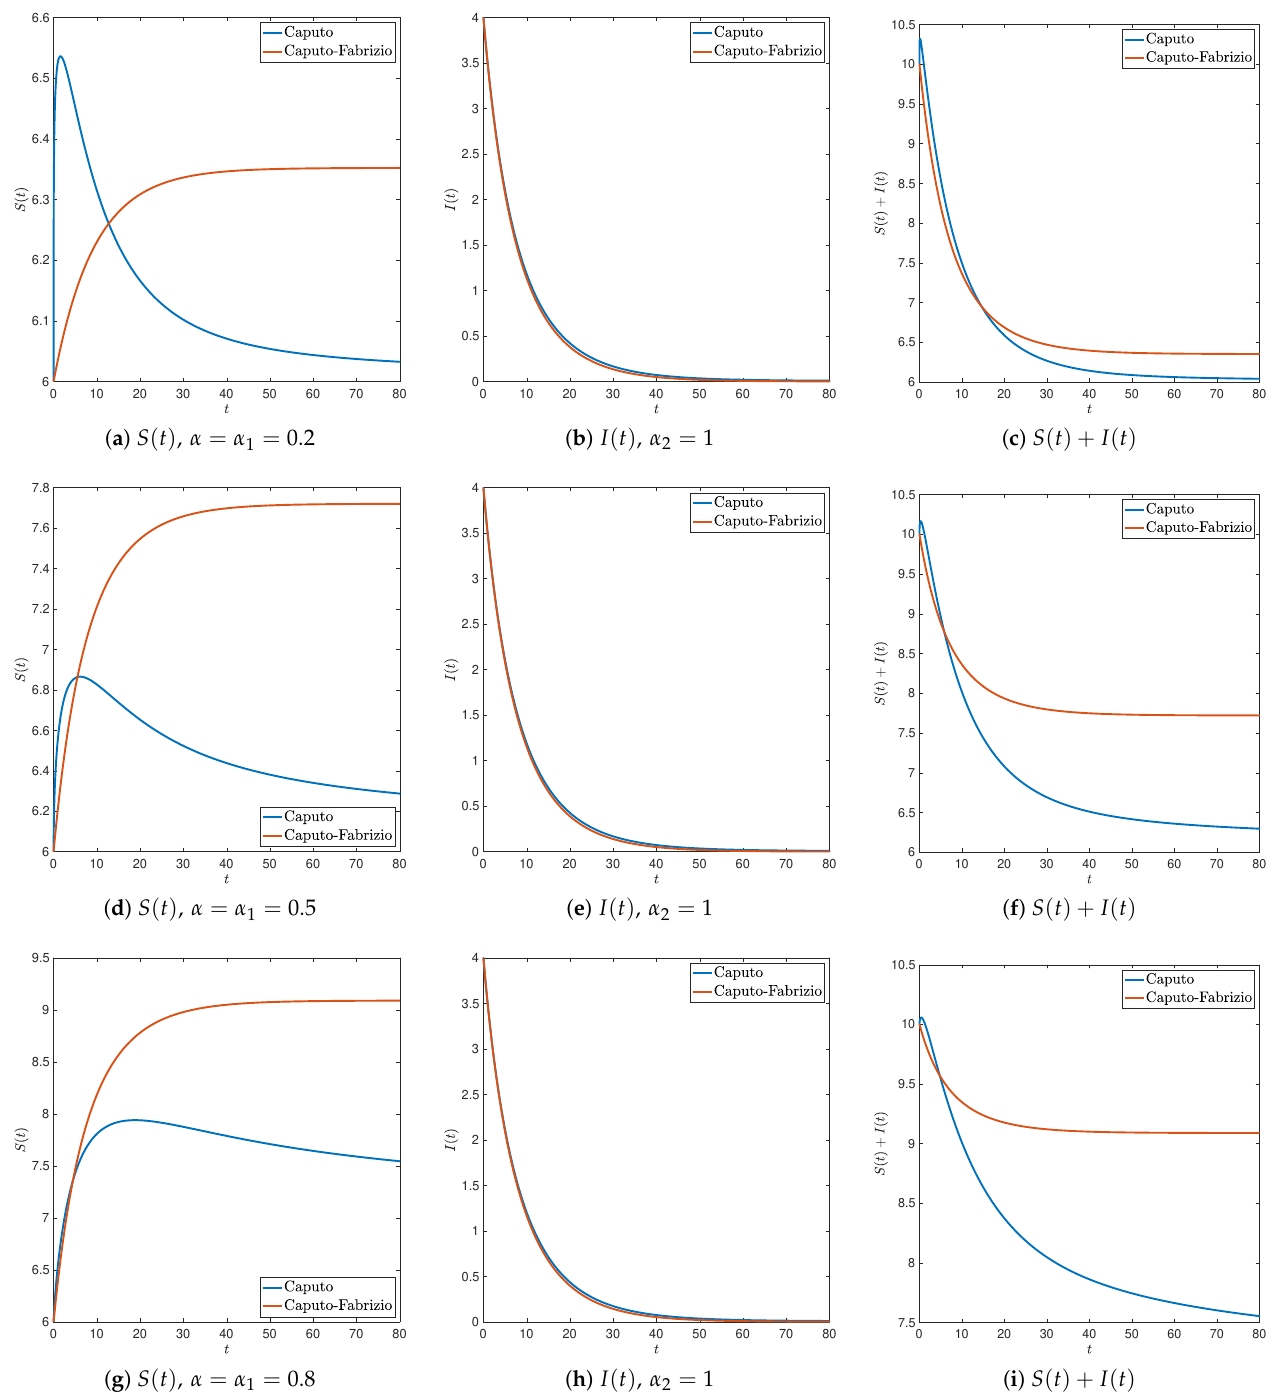
Figure 8. Numerical solutions to (1) and (2) for α 1 = 0.2 (top), α 1 = 0.5 (center) and α 1 = 0.8 (bottom) with α 2 = 1, β = 0.1, γ = 0.2, S 0 = 6, I 0 = 4 and M ( α ) ≡